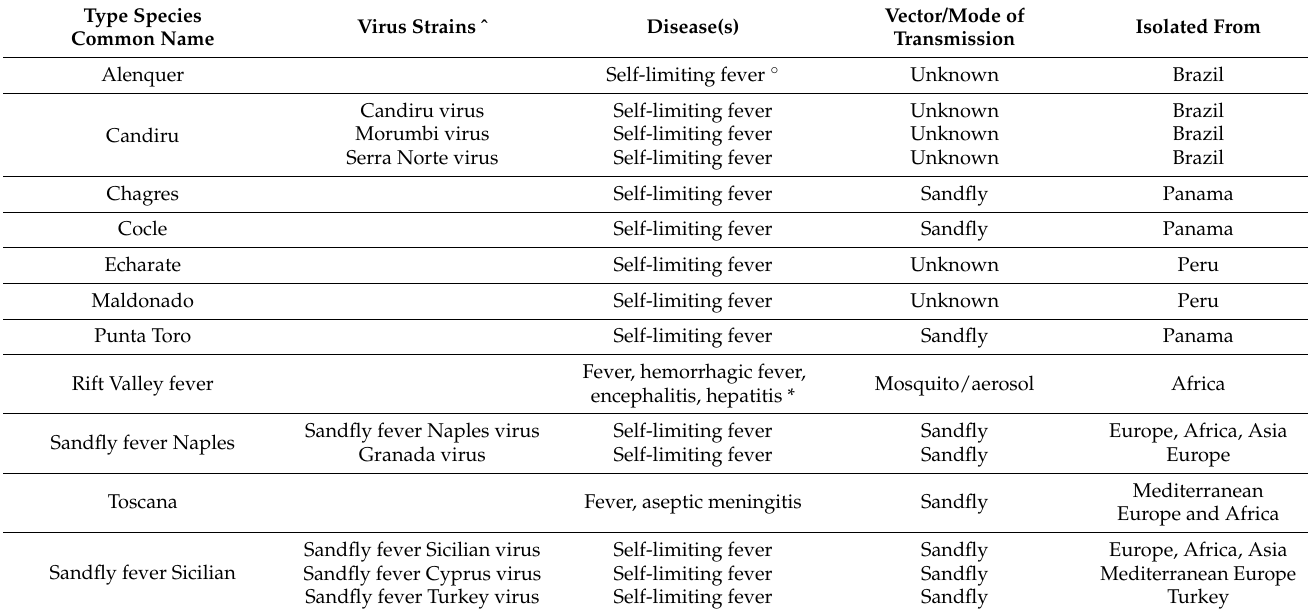
Table 1. Known human pathogens of the genus Phlebovirus and typical associations